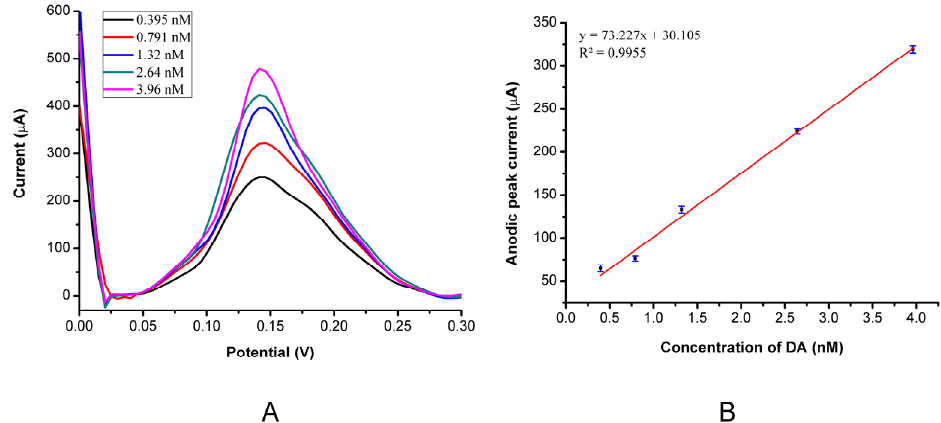
Figure 4. Optimization of DA and kinetic parameters. ( A ) Voltammograms of the MIP PGE sensor response for DA concentrations by DPV; ( B ) Calibration of DA concentration in a range of (0.395–3.96 nM).